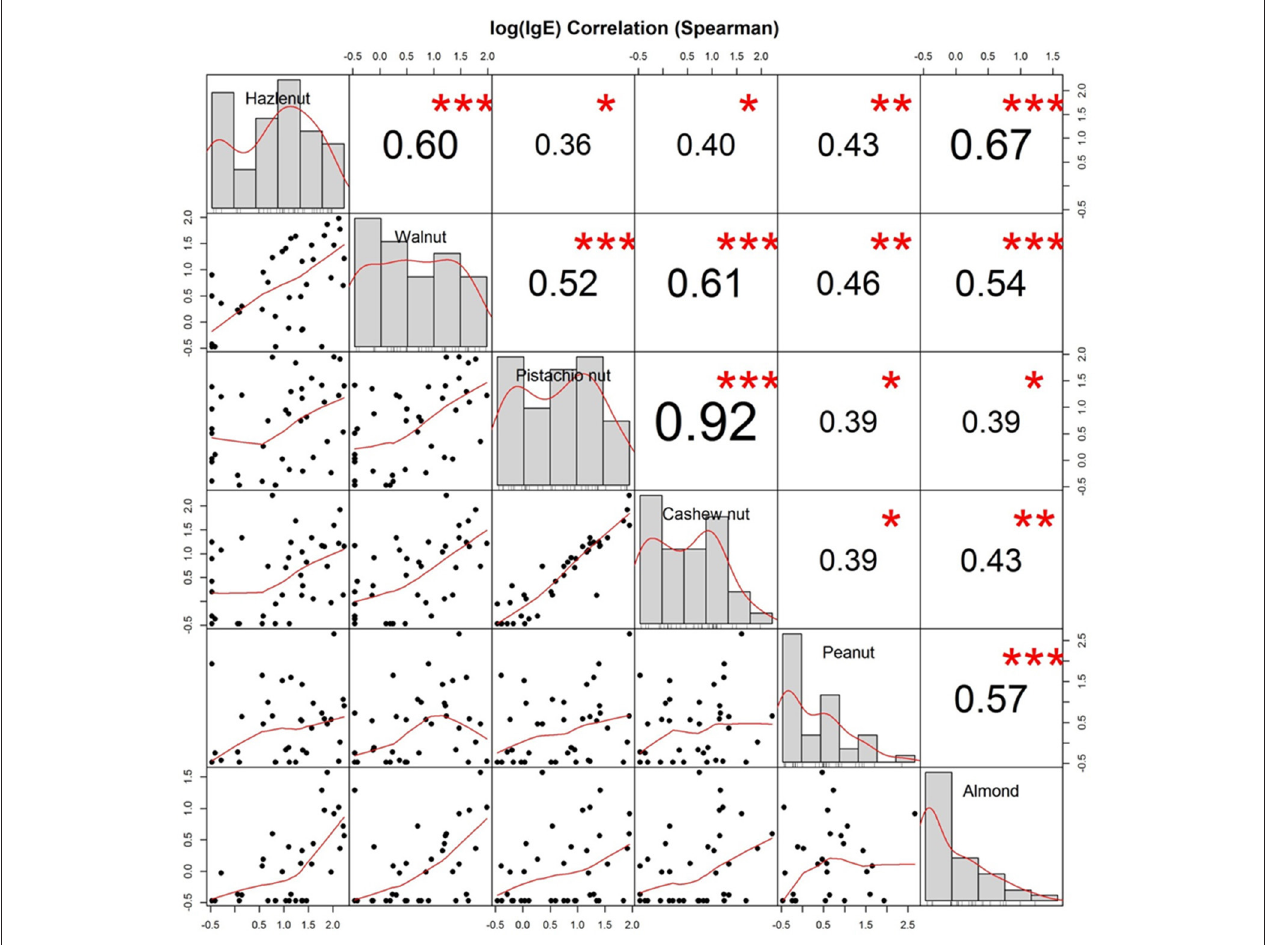
FIGURE 4 | Distribution and allergen-specific IgE correlations between nuts. Distribution (diagonal), Scatterplots (bottom of diagonal), and Spearman correlation coefficients (top of diagonal) between allergen-specific IgE toward whole extracts of hazelnut, walnut, cashew nut, pistachio nut, peanut, and almond from all 40 participants. Logarithmic values of IgE are shown. Stars indicate level of significance: p ( < 0.001, < 0.01, and < 0.05) < , = , > symbols (***, **,